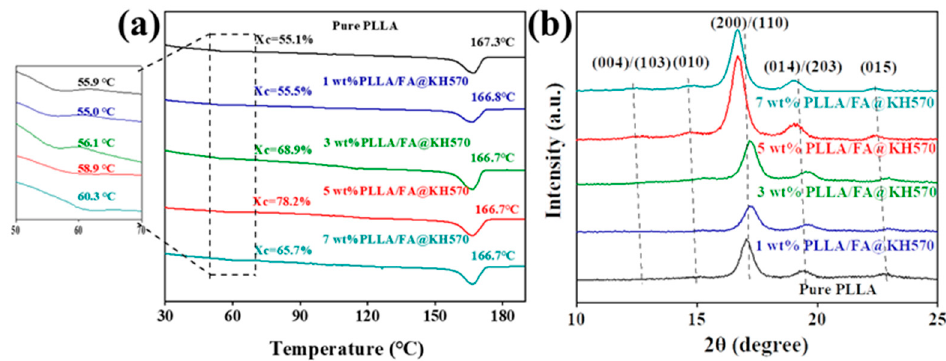
Figure 6. ( a ) DSC heating curves of pure PLLA and PLLA/FA@KH570 composites. ( b ) XRD patterns of pure PLLA and PLLA/FA@KH570 composites.